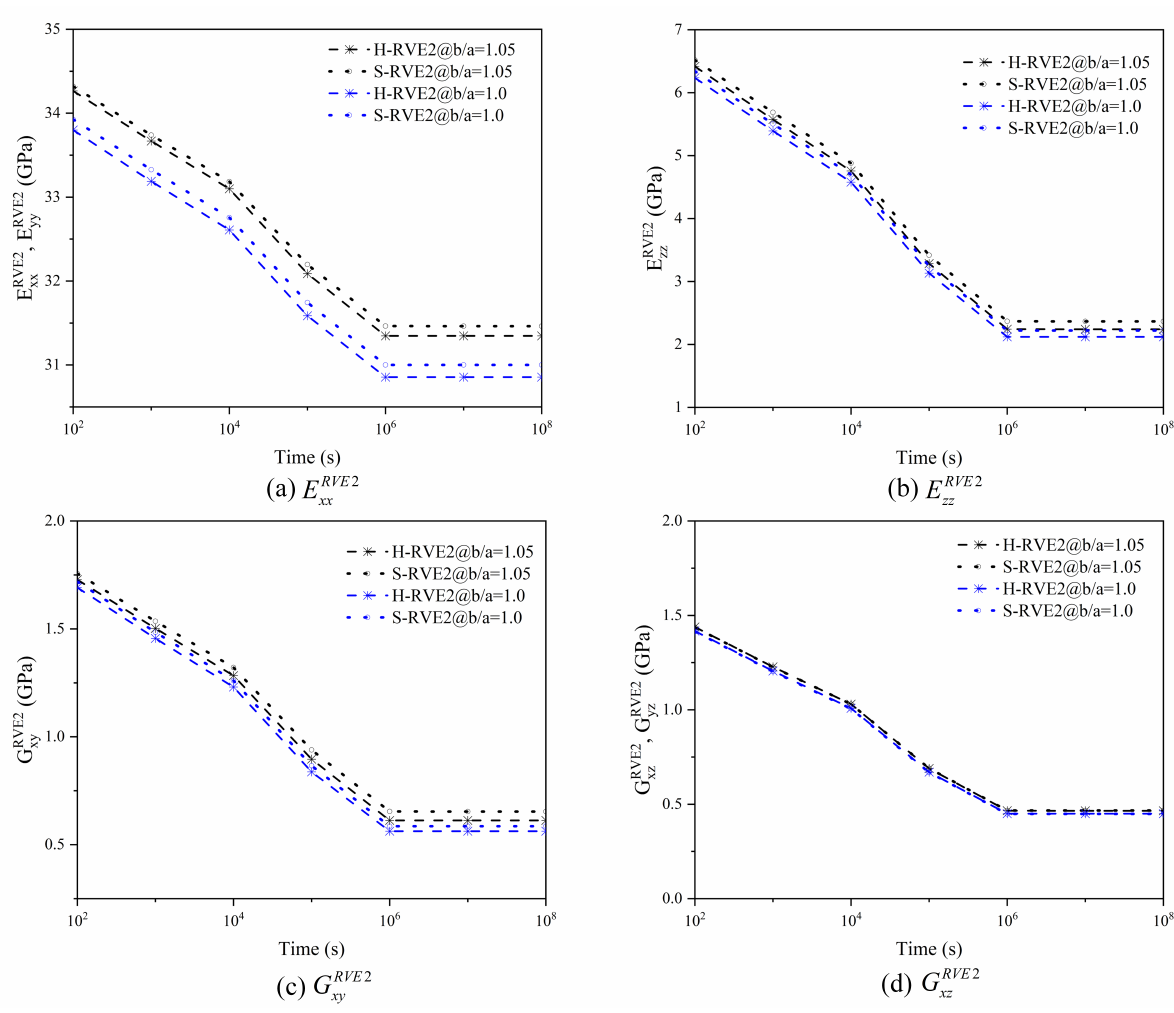
Figure 13.Figure 13. Effect of the coating thinkness on effective relaxation moduli of 2D woven